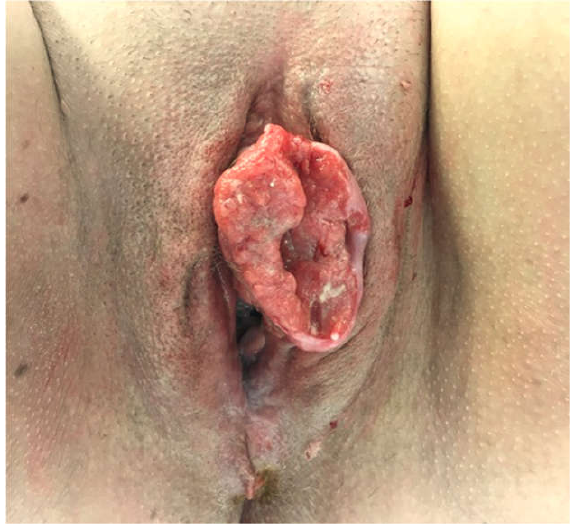
Figure 2. Case no. 20. A patient with a left unilateral 55 mm × 30 mm squamous cell carcinoma of the vulva, extending to the midline anteriorly. She was treated via radical local excision of the primary cancer, left inguinofemoral lymphadenectomy, and serial ultrasonography of the right groin. Five patients met criterion (3), having small multifocal invasive lesions following the resection of apparent in situ disease. Three of these patients had Paget’s disease, and two had squamous cell carcinomas (Table 3). Table 3. Patients with mainly in situ carcinomas that demonstrated small, multifocal invasive dis- ease on resection. The largest individual invasive focus was 20 mm or less in diameter. Patient Number